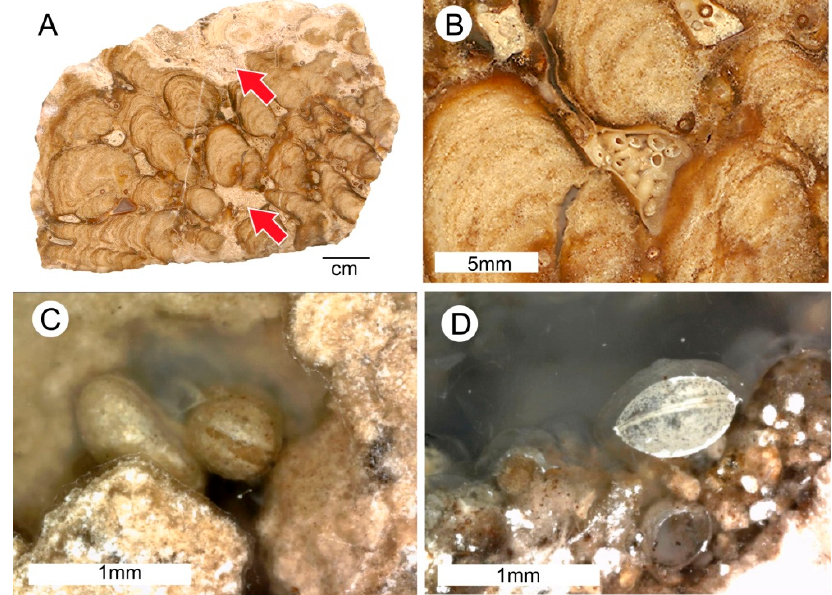
Figure 10. Ostracods in stromatolitic calcium carbonate from Lake Gosiute. ( A , B ) Stromatolite with ostracod valves in spaces between algal masses. ( C , D ) High-magnification views of individual ostracod shells.